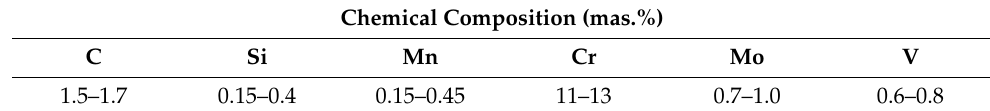
Table 1. Chemical composition of AISI D2 steel (EN X153CrMoV12) [36]. Chemical Composition (mas.%)